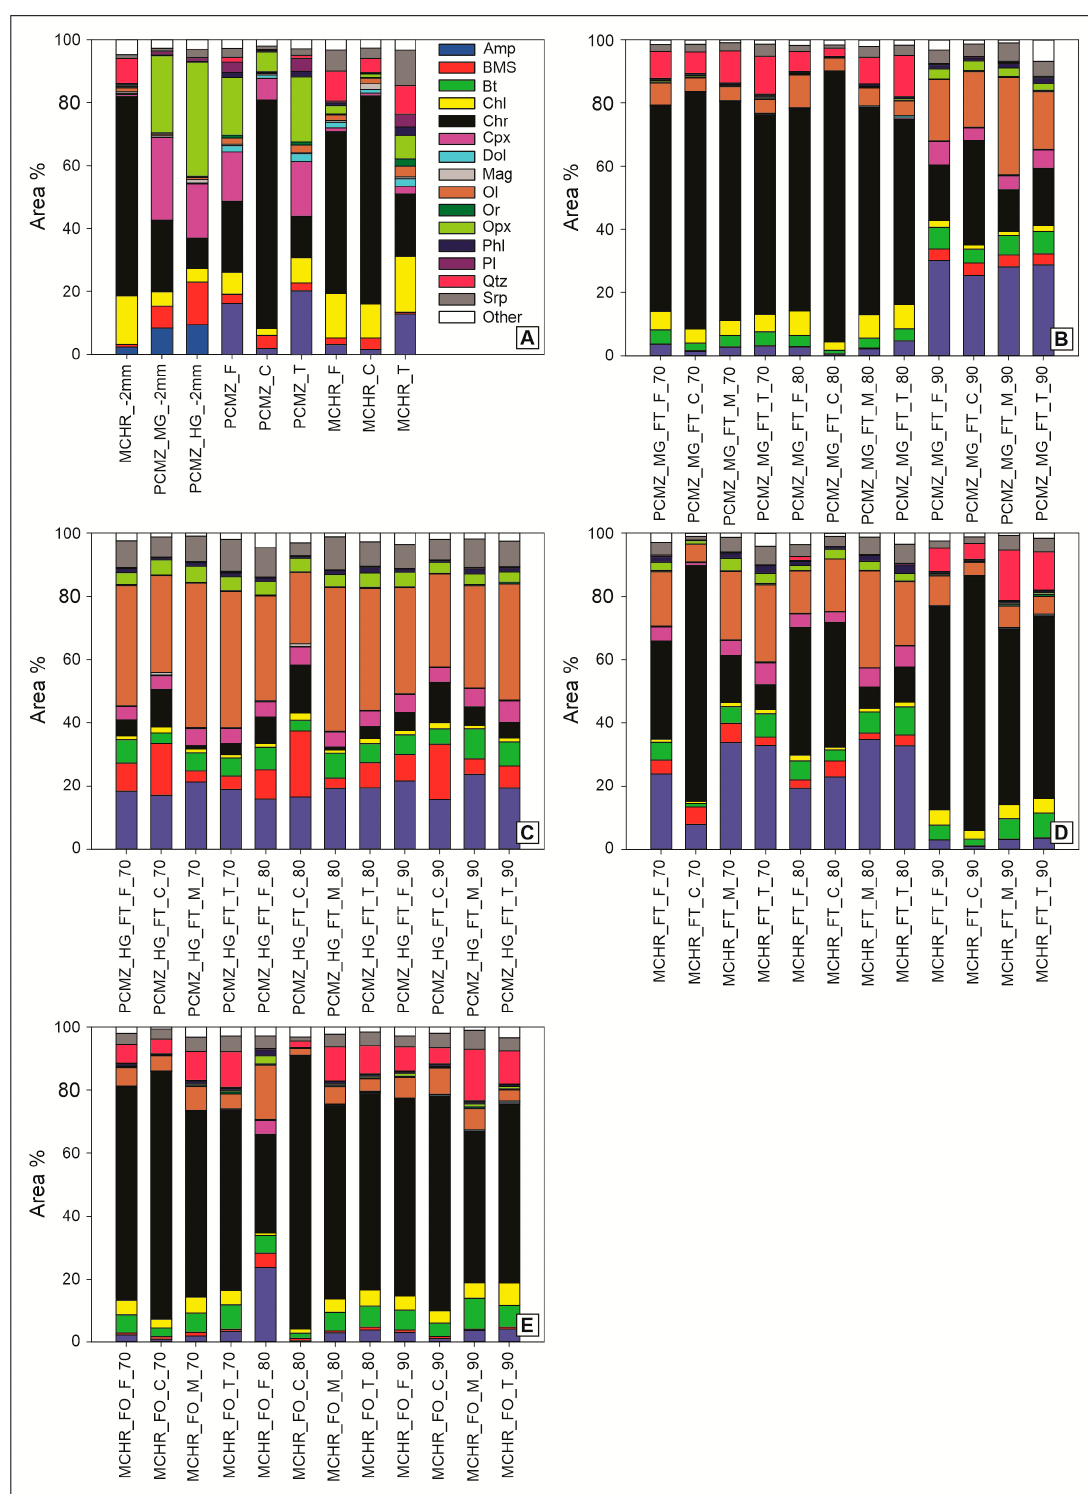
Figure 6. Modal mineralogy of all the samples analyzed in this study at the three target grinds. ( A ) = Modal mineralogy of the unprocessed ore ( − 2 mm crush) and concentrator plant (denoted by the suffixes, F, C, T). ( B ) = Modal mineralogy of the PCMZ_MG. ( C ) = Modal mineralogy of the PCMZ_HG. ( D ) = Modal mineralogy of the MCHR_FT. ( E ) = Modal mineralogy of the MCHR_FO. ( E ) Mineral abbreviations after [60].